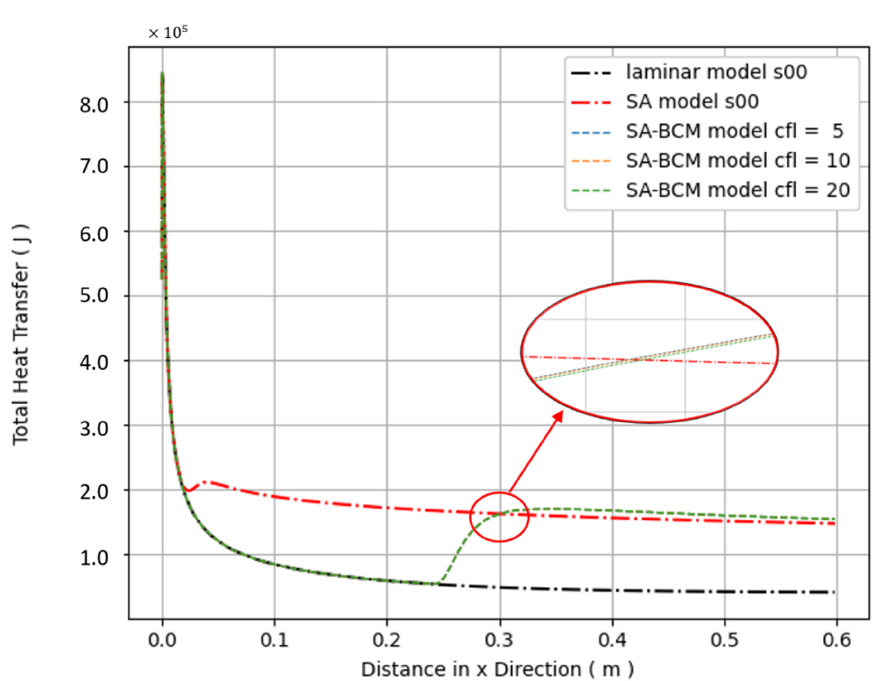
Figure 5. Grid convergence study of max CFL value.